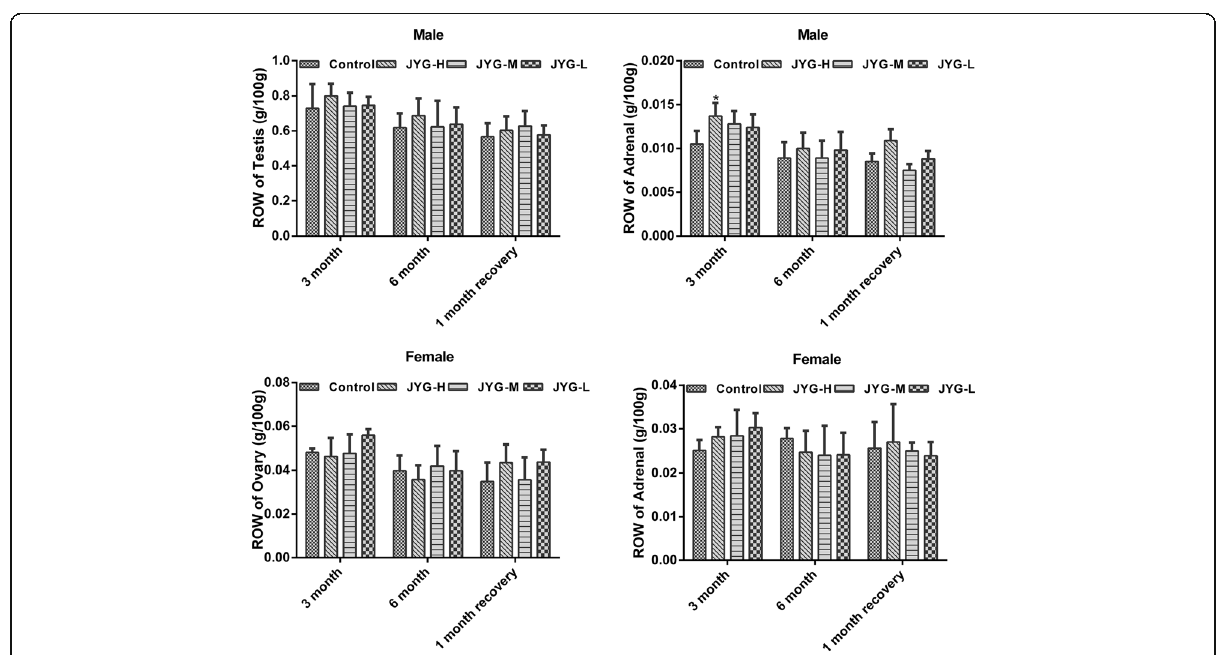
Fig. 8 Relative organs of testis, ovary, and adrenal gland in the control and JYG-treated groups in the chronic toxicity test. Note: ROW: relative organs weight; JYG-H, JYG-M, JYG-L: Jueyin granules high-dose, medium dose, low-dose group, respectively. The values are expressed as mean±SEM (n=10 rats for 3 months; n=17 – 19 rats for 6 months; n=10 rats for 1 month recovery). * P <0.05 statistically significant compared to control